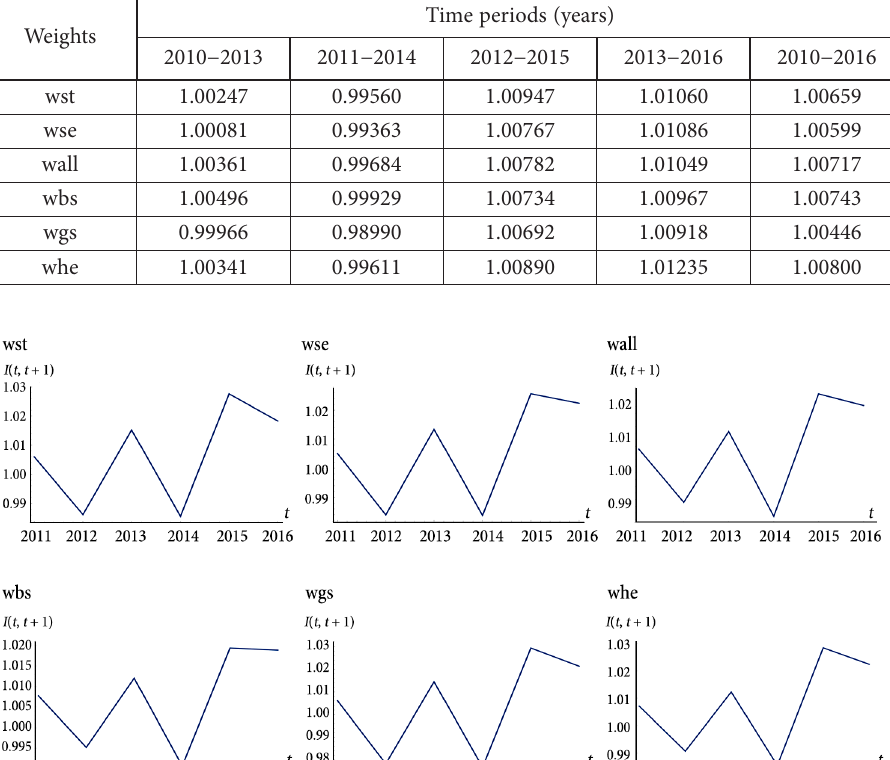
Table 4. The average innovativeness change ( , ) I s t calculated for the EU-28 (source: own elaboration based on the data of the European Statistical Office – Eurostat and European Commission, 2018. Eu- ropean Innovation Scoreboard 2018)